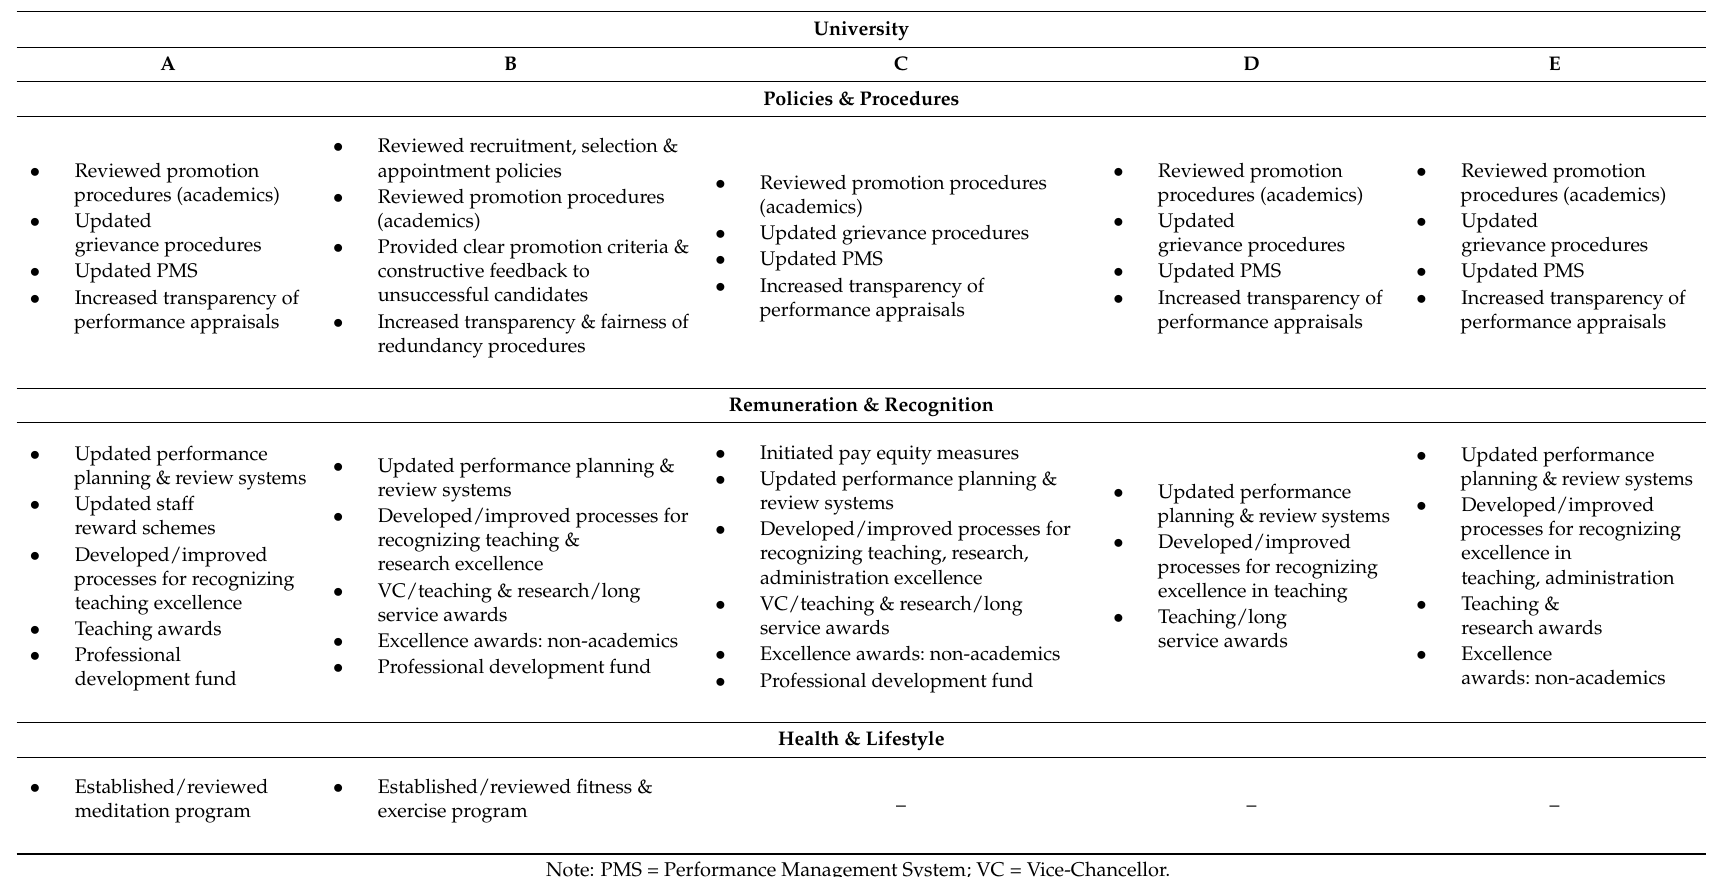
Table 7. Interventions to Enhance Fair Procedures, Remuneration, Recognition and